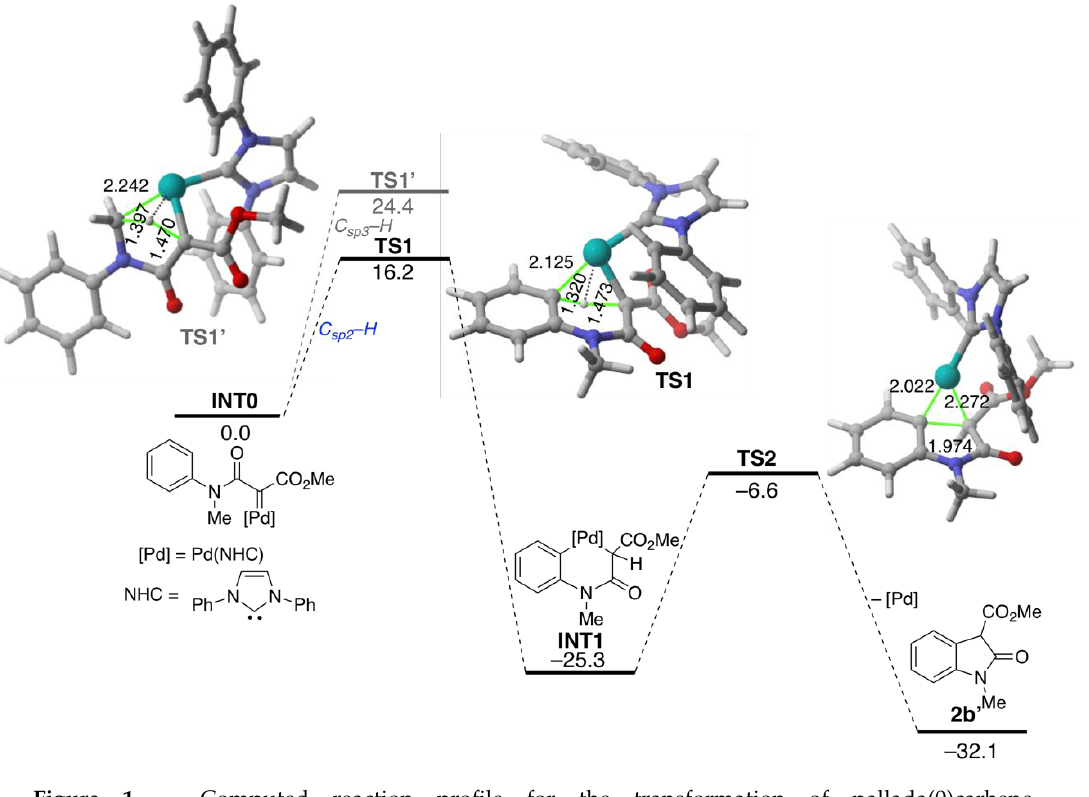
Figure 1. Computed reaction profile for the transformation of pallada(0)carbene INT0 into oxindole 2b’ : Relative free energies and bond distances are given in kcal/mol and angstroms, respectively. All data have been computed at the PCM(dichloroethane)-B3LYP-D3/def2-TZVPP//PCM(dichloroethane)-B3LYP-D3/def2-SVP level.